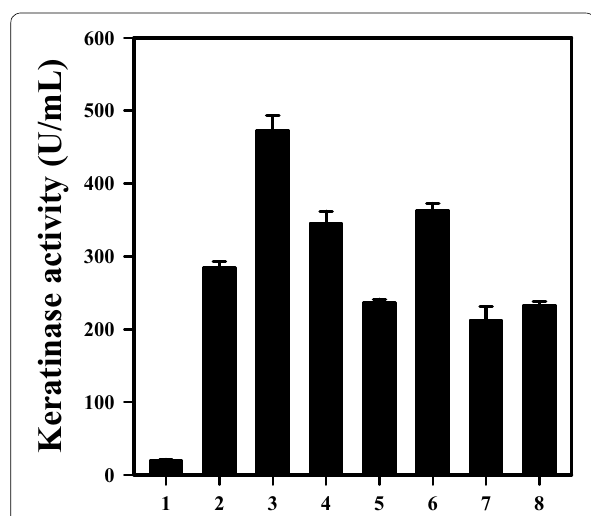
Fig. 3 Production of KerP by recombinant B. subtilis . Lanes: 1, PT5; 2, PT5(DMT‑KerP); 3, PT5(DMT01‑mKerP); 4, PT5(MT07‑mKerP);